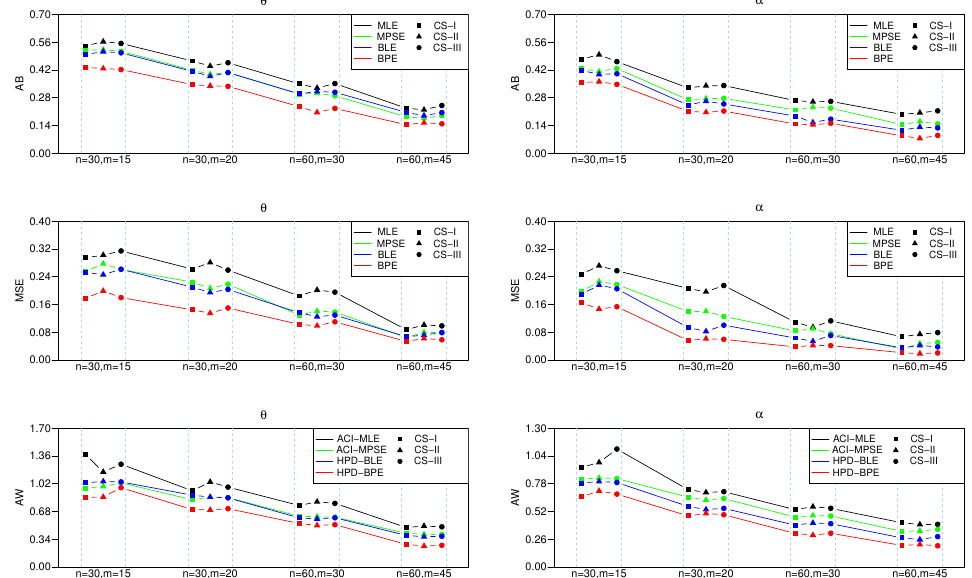
Figure 2. Plots of AB, MSE and AW for the model parameters at ( α , θ ) = ( 2.1,1.3 )